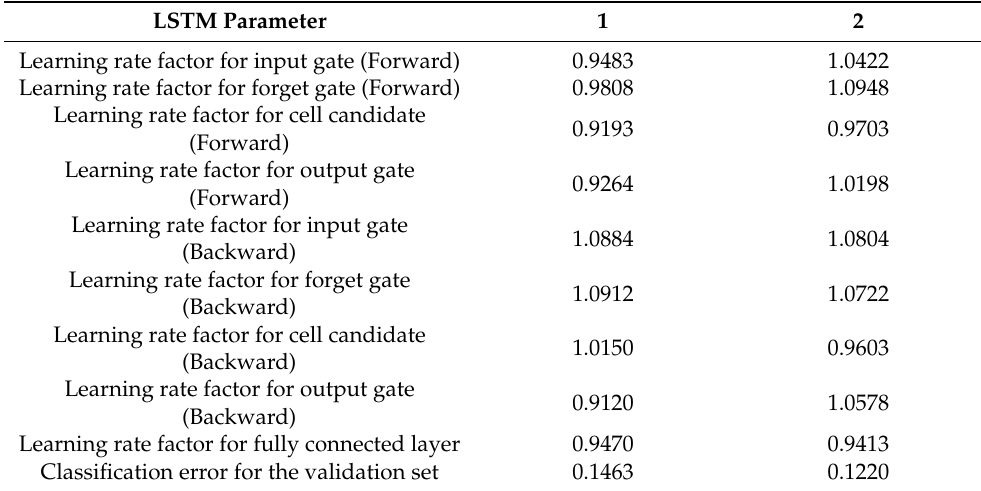
Table 7. The values of LSTM parameters for the evaluations of BA (ECG dataset). LSTM Parameter